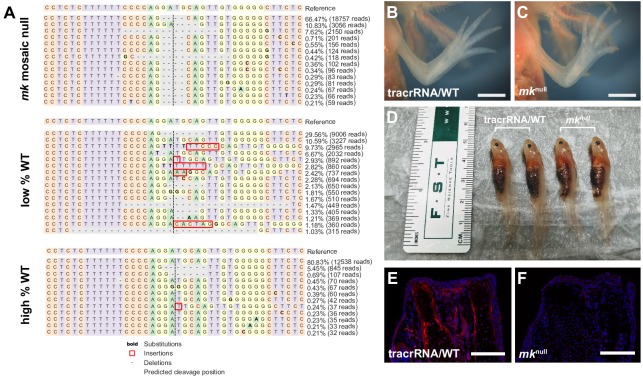
CRISPR generation of mk mosaic null mutants.(A) Example genotyping results of fully modified (mosaic null, abbreviated mknull) or partially modified (low % or high % WT) animals. (B–C) Representative brightfield images of tracrRNA control and mknull forelimb of four-month old sibling axolotls. (D) Side-by-side brightfield image of tracrRNA control and mknull axolotls demonstrating no gross observational difference in body size. (E–F) Representative MK immunostaining of a tracrRNA control or mk mosaic null mutant at 7 dpa reveals a loss of staining. Scale bars, B-C: 2 mm, E-F: 500 µm. dpa, days post-amputation.